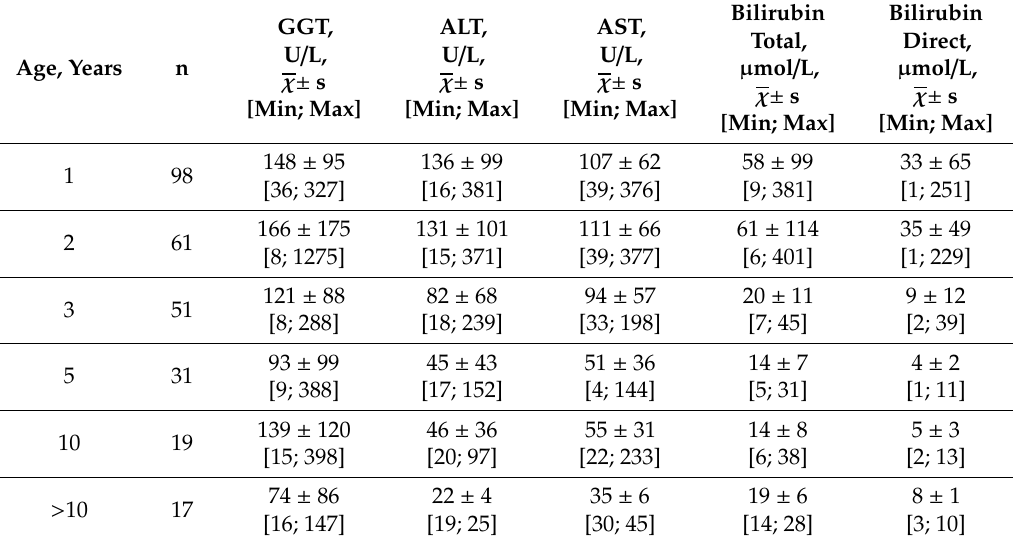
Table 2. Age-dependent dynamics of native liver function indicators in the follow-up of Kasai surgery (the values are given as χ ± s [min;